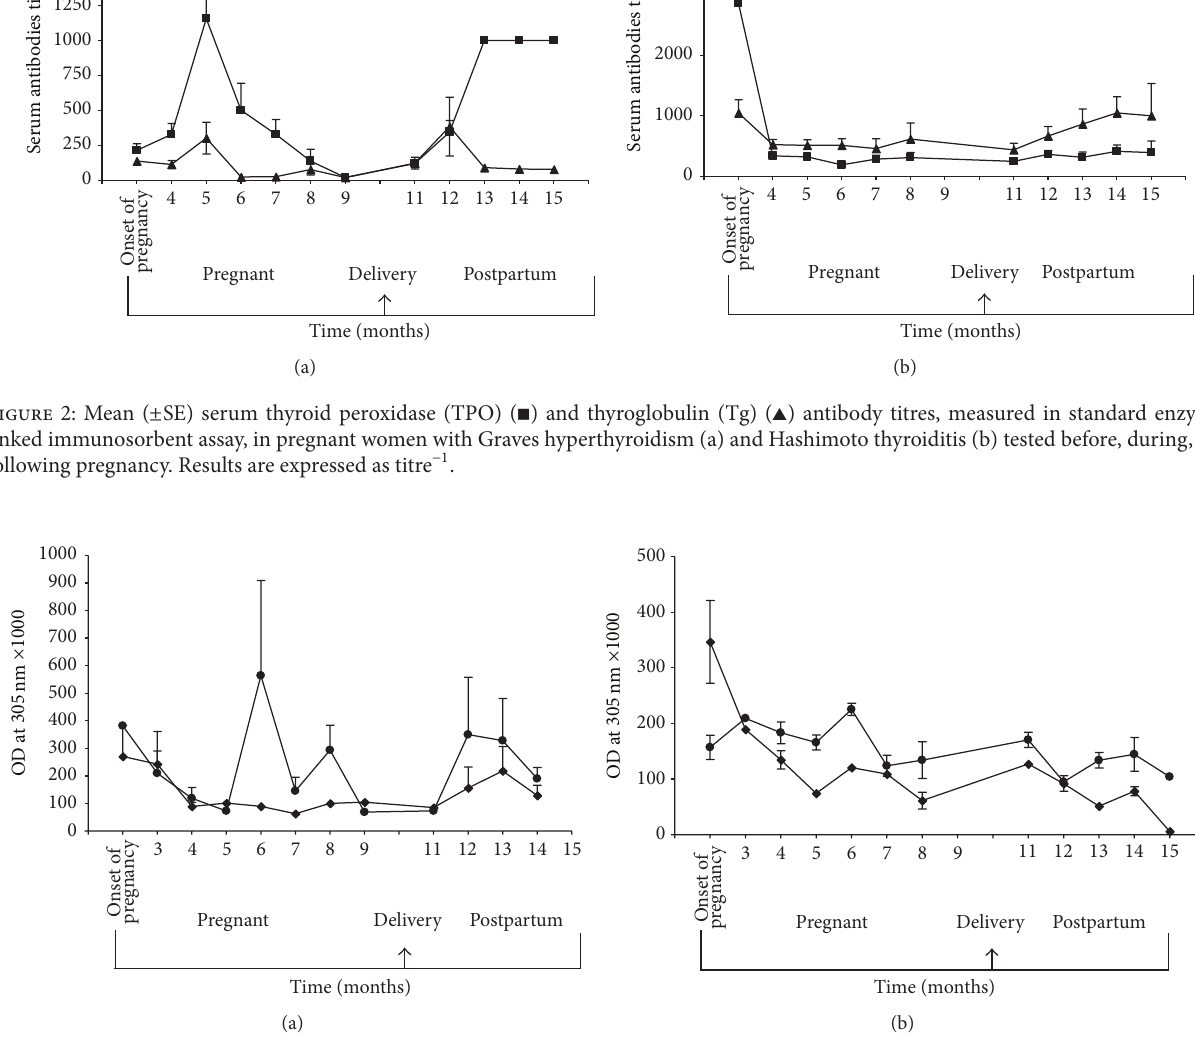
Figure 3: Mean ( ± SE) serum calsequestrin ( e ) and collagen XIII ( X ) antibody titres, measured in standard enzyme-linked immunosorbent assay, in pregnant women with Graves hyperthyroidism (a) and Hashimoto thyroiditis (b) tested before, during, and following pregnancy. Results are expressed as optical density (OD) at 305 nm ×